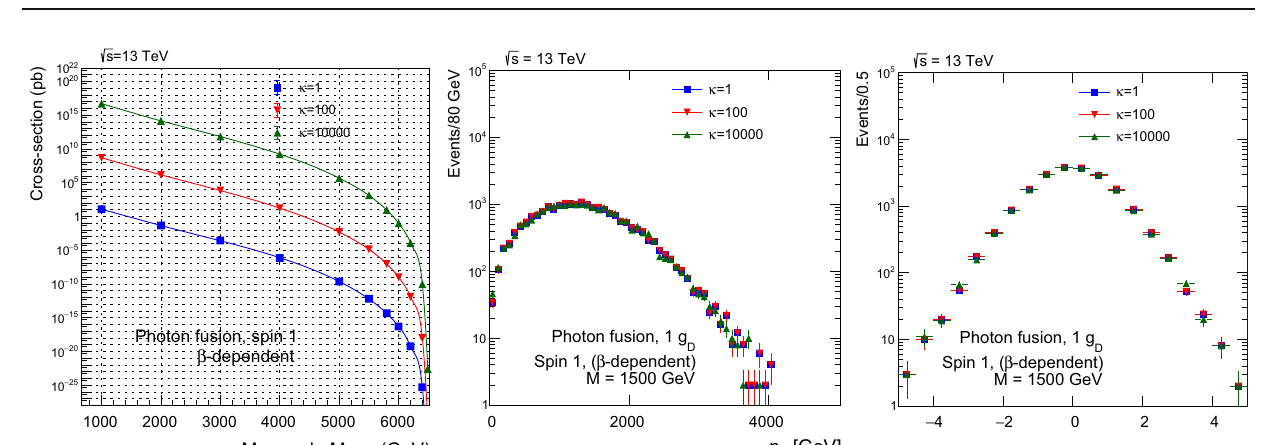
√ Fig. 27 Photon-fusion productionat s = 13TeV pp collisionsforspin-1monopole, β -dependentcouplingandvarious valuesofthe κ parameter: cross section versus monopole mass (left); p T distribution for M = 1500 GeV (centre); and η distribution for M = 1500 GeV (right)